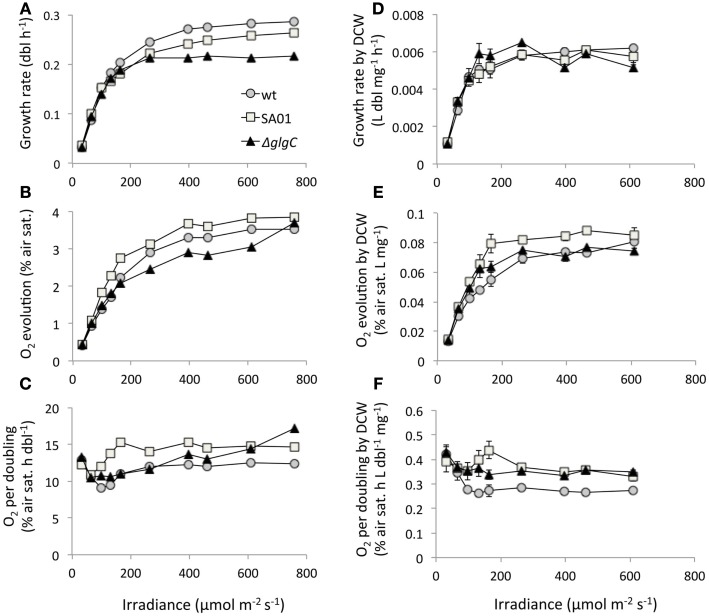
Growth rates, O2 evolution, and dry cell weight (DCW) normalization of steady-state PBR cultures by light intensity. (A) Doubling rate, (B) bulk O2 evolution, (C) O2 production normalized to growth rate, (D) doubling rate per unit DCW, (E) O2 evolved on the basis of DCW, and (F) per-doubling O2 evolution normalized to DCW. Values for DCW at 759 μmol m−2 s−1 were not available. Light intensity is reported as spherical irradiance. Error bars represent SD over three samplings at each light intensity.